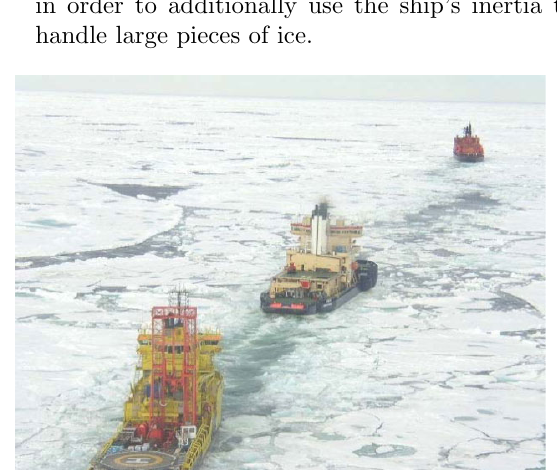
Figure 1: Arctic Oil and Natural Gas Provinces Map. Courtesy: Geology.com (2014)